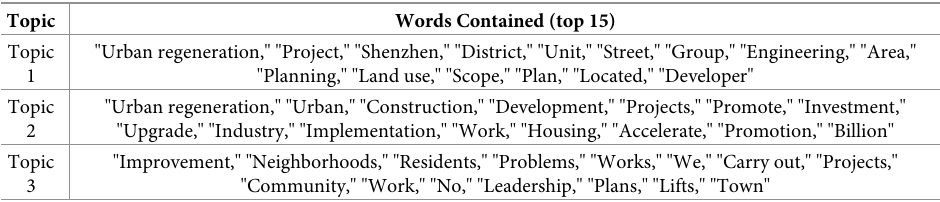
Table 2. Topic categorization of all comments based on the LDA